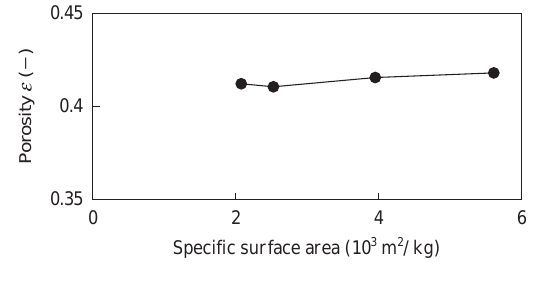
Relation between specific surface area and porosity of ground alumina particle layer after heat treatment at 827K